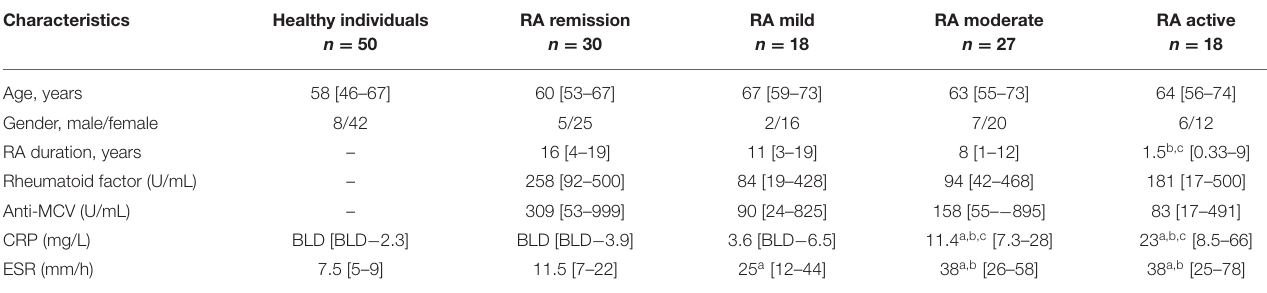
TABLE 1 | Clinical characteristics of healthy individuals and RA